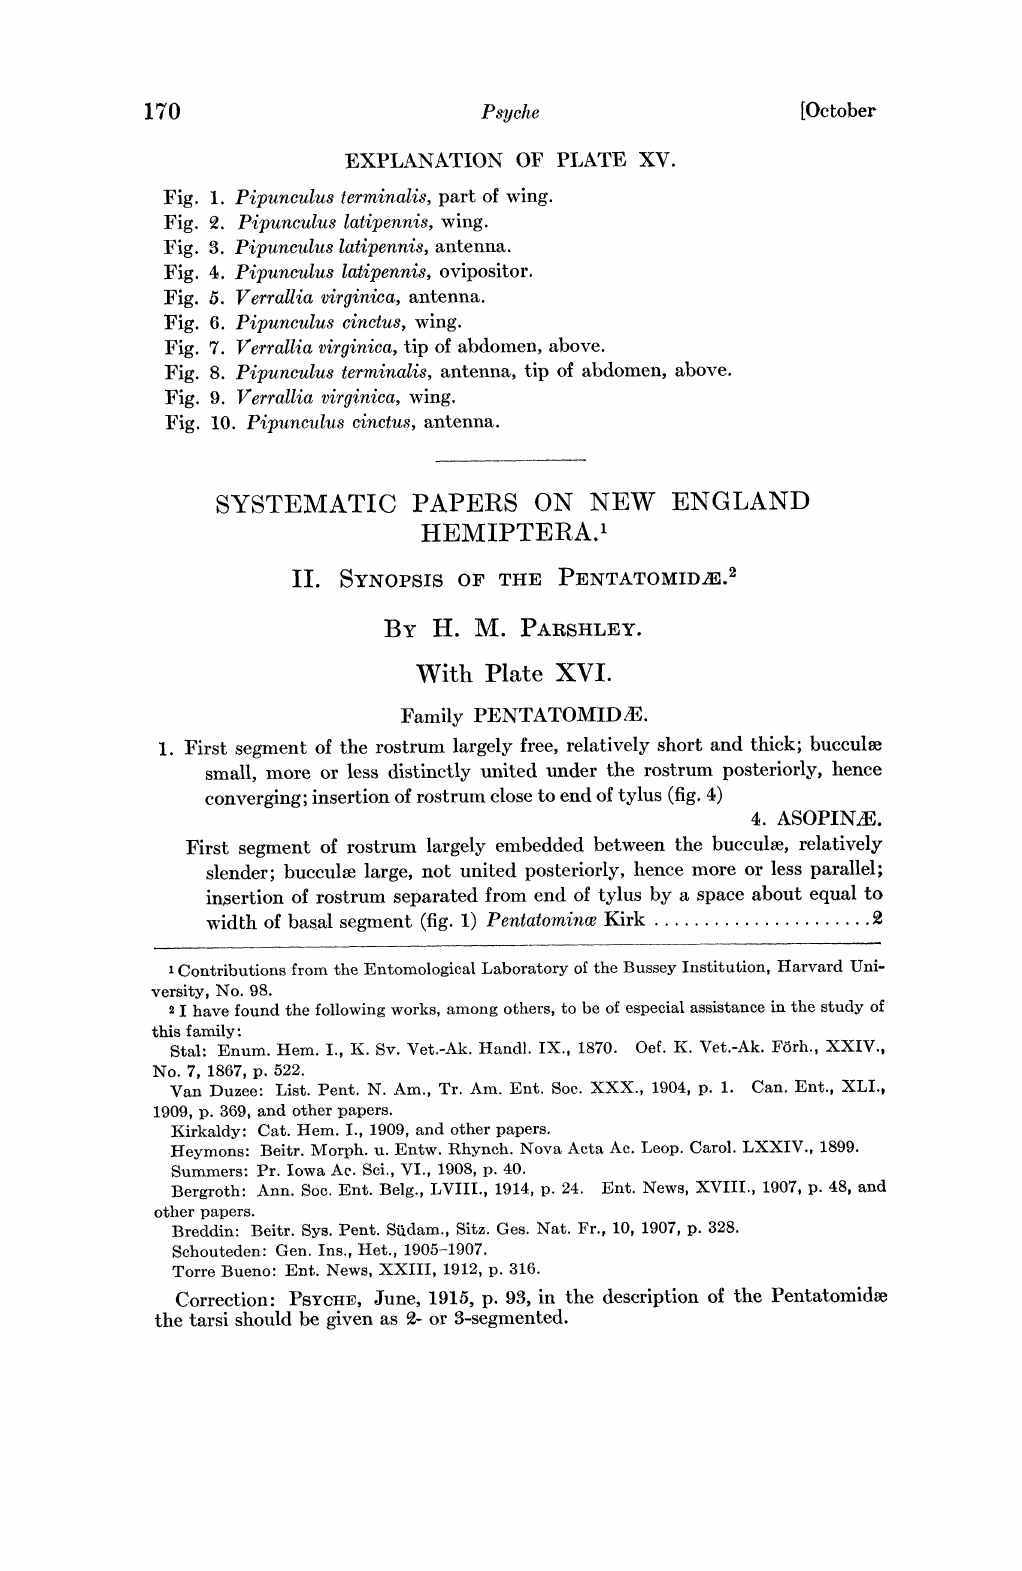
.. Fig. 1. Pipunculus terminalis, part of wing. Pipunculus latipennis, wing. Fig. Fig. 3. Pipunculus latipennis, antenna. Fig. 4. Pipunculus latipennis, ovipositor. Fig. 5. Verrallia virginica, antenna. Fig. 6. Pipunculus cinctus, wing. Fig. 7. Verrallia virginica, tip of abdomen, above. Fig. 8. Pipunculus termiualis, antenna, tip of abdomen, above. Fig. 9. Verrallia virginica, wing. Fig. 10. Pipunculus cinctus,